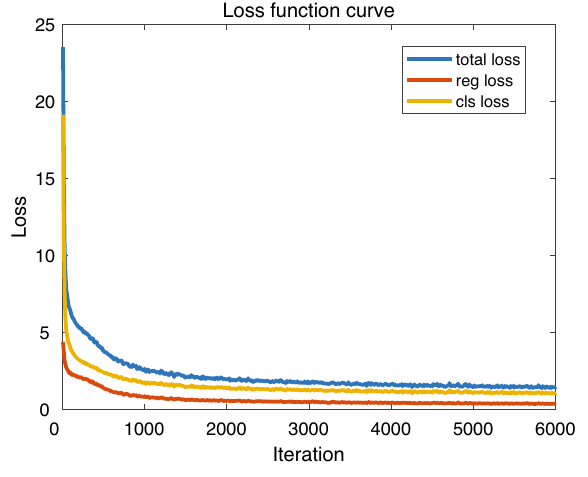
Figure 12. Change of loss function.